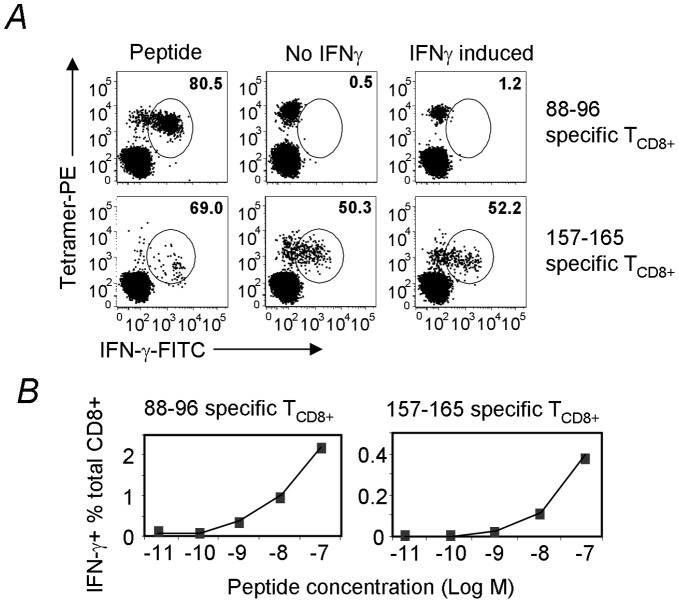
NY-ESO-188–96 is not naturally presented by melanoma cells.
A, NY-ESO-1157–165– and NY-ESO-188–96–specific TCD8+ lines were expanded from PBMCs collected from the previously reported patient 7 [6] and patient 8 with 18 mer peptides NY-ESO-1157–174 and NY-ESO-179–96 respectively. These T cells were then co-incubated with tumor line (SK-MEL-8) with or without a 48 hr IFN-γ induction (see Materials and Methods for details). The untreated SK-MEL-8 cells were also pulsed with both peptides followed by washing out excessive peptides to serve as a maximum antigen presentation control. Antigen-specific T cell activation was then revealed by tetramer and IFN-γ double staining. Percentage represents antigen-specific, IFN-γ-producing cells amongst total tetramer positive cells (note, the double negative cell population was not included in the percentage calculation). B, the same TCD8+ lines used in A were also assessed for their affinity by peptide titration. Percentage represents Ag-specific T cells among total CD8+ T cells. Similar data were obtained from three similar experiments.